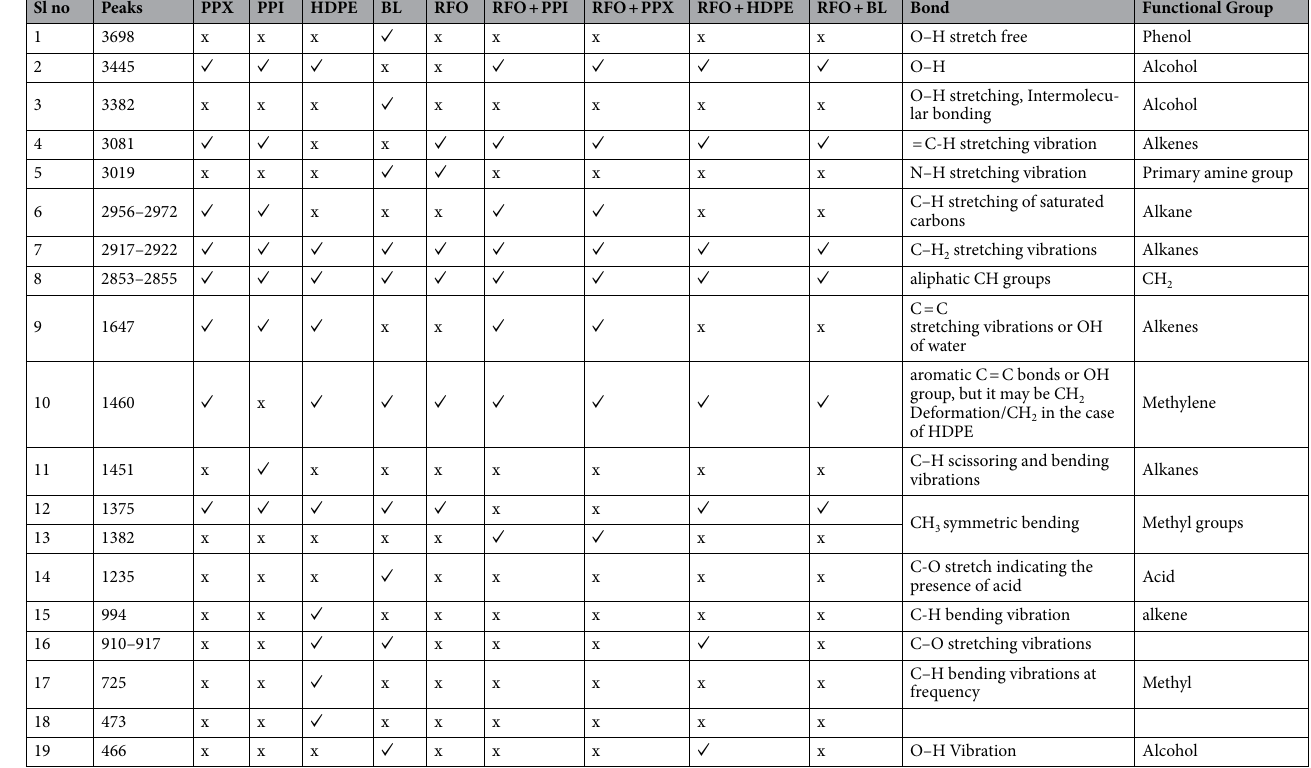
Table 2. List of the prominent peaks of FTIR analysis of the liquid products obtained from the co-cracking of RFO with waste plastics.